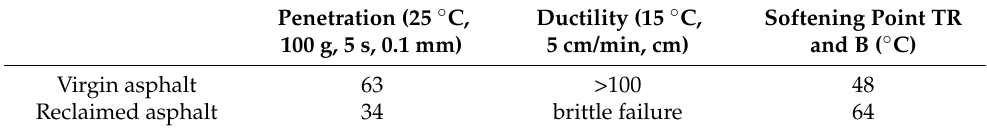
Table 1. The properties of asphalt binder.